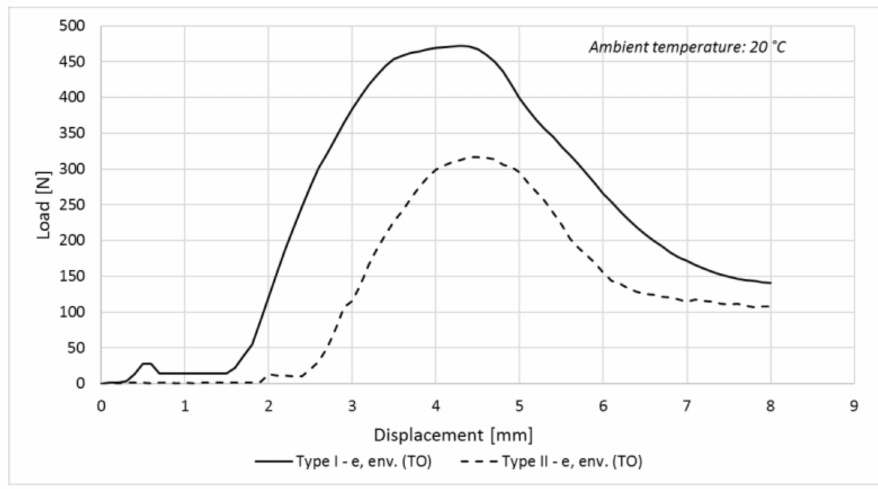
Figure 21. Closing force curves obtained at environmental temperature–piston with toroidal shape.